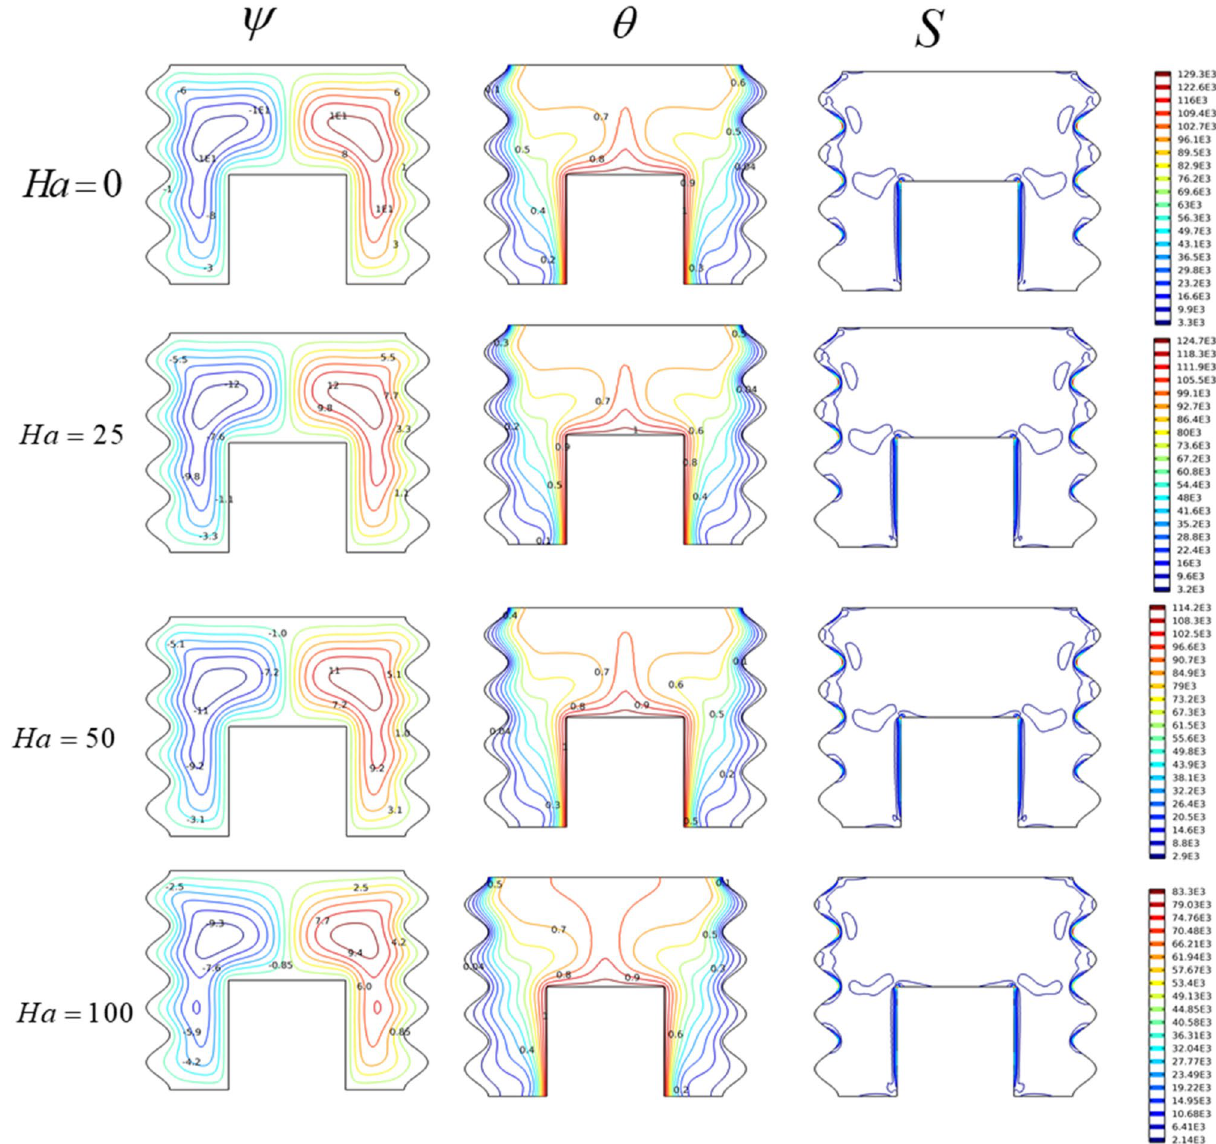
Figure 4. The impact of Ha on (ψ) Streamlines, (θ) Isotherms, and (S) Entropy for Da = 10 –2 , Ra = 10 6